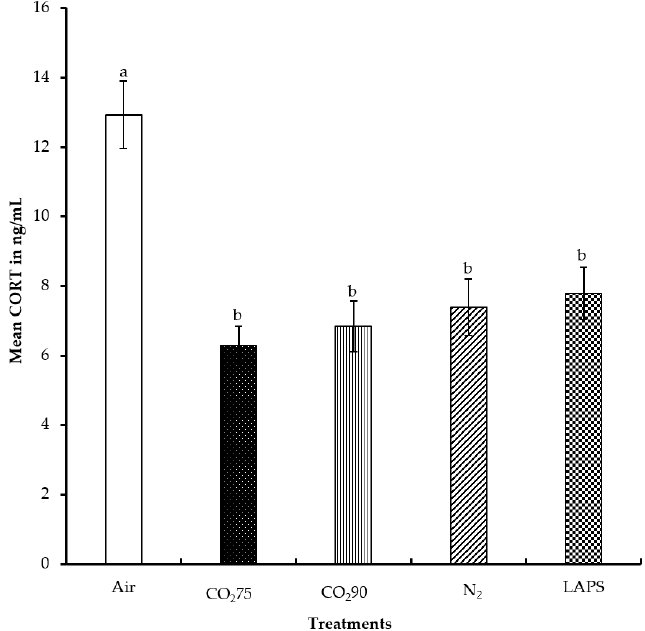
Figure 4. Mean serum corticosterone levels of male layer chicks. The CORT concentrations were measured in duplicate and expressed in ng/mL. Bars (mean ± SEM) with different superscripts (a,b) are significantly different by Fisher’s LSD test ( p < 0.05). Number of samples per treatment was 100.